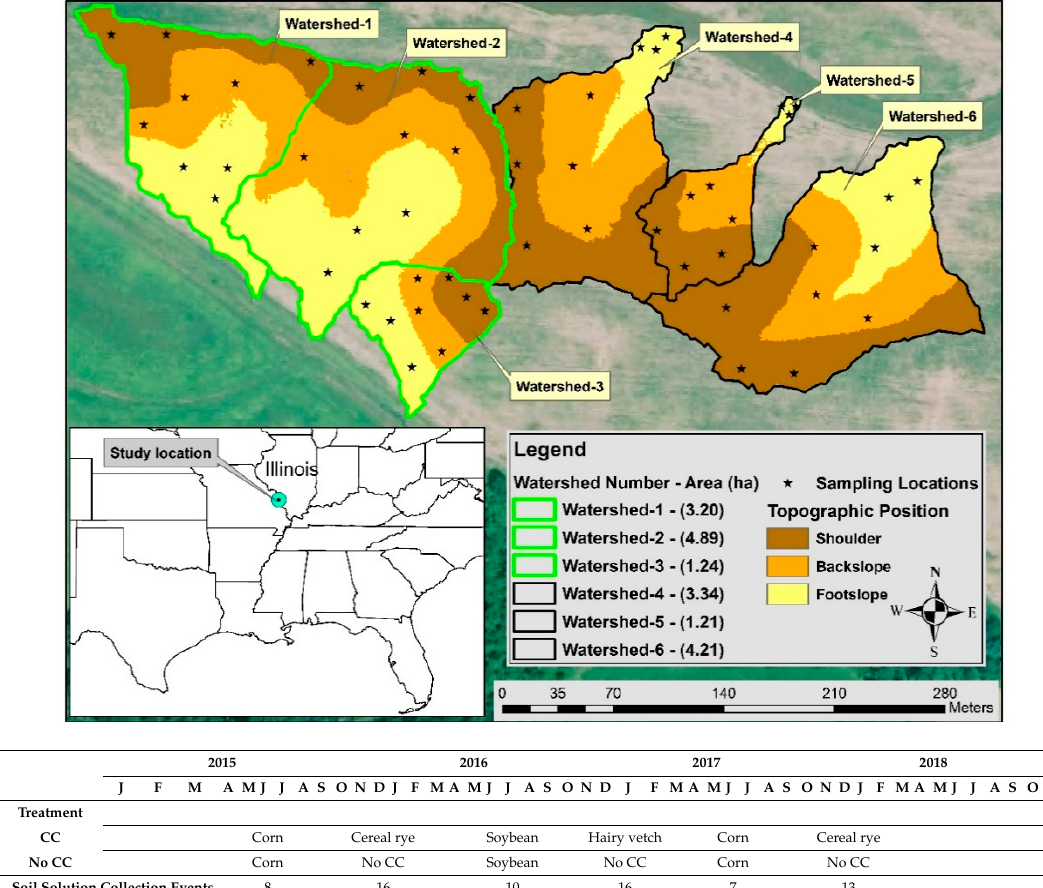
Figure 1. Cover crop research site at Carbondale, Illinois USA. Crop rotation followed was no-till corn-cereal rye-soybean-hairy vetch in watersheds planted with cover crops (CCs) indicted by the green outline and corn-no cover crop (no CC)-soybean-no CC in control watersheds indicated by the black outline. Soil solution collection events are the total number of water sampling events per cropping season from planting until harvest/termination of crops.